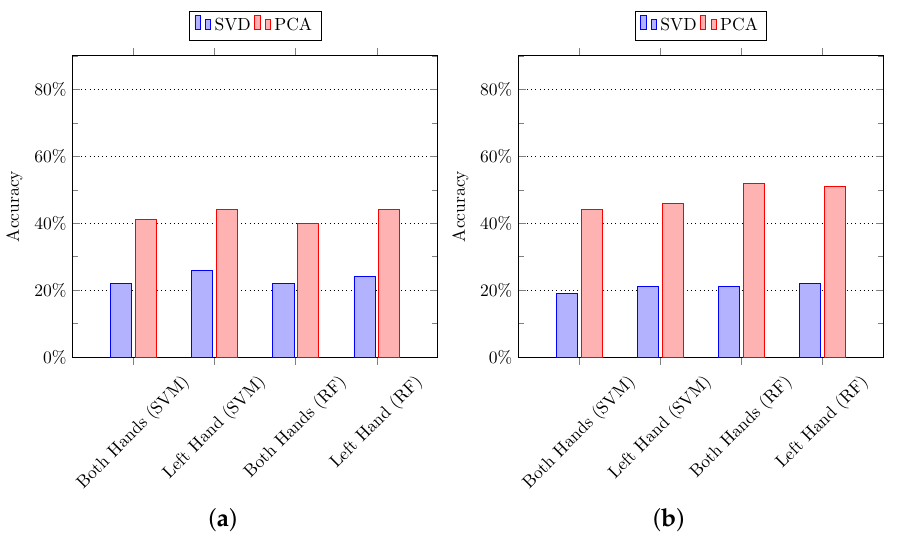
Figure 7. The composite activity recognition using features derived from the subspace pooling technique. The features are classified using Support Vector Machine (SVM) and Random Forest (RF).